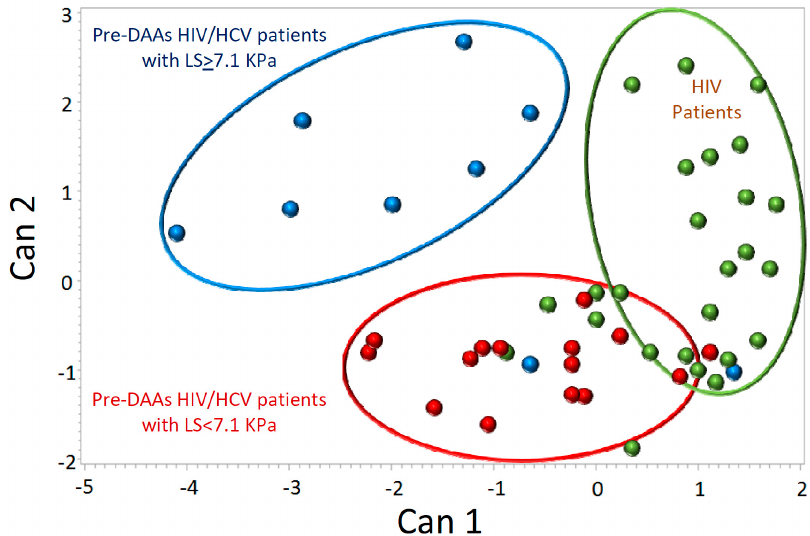
Figure 4. Canonical discriminant analysis comparing the phenotypic profile of T cells between HIV patients (green dots), pre-DAAs HIV/HCV coinfected patients with liver stiffness (LS) < 7.1 Kpa (red dots) and pre-DAAs HIV/HCV coinfected patients with LS ≥ 7.1 Kpa (blue dots).